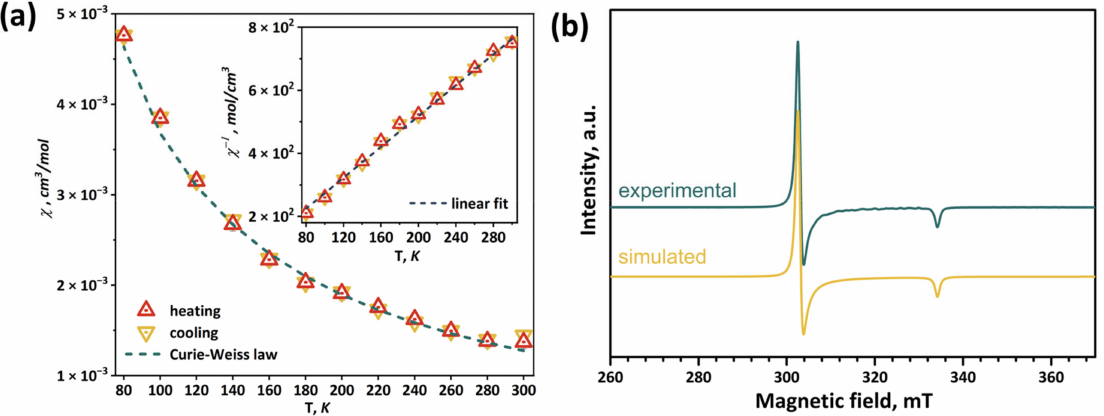
Figure 8. Temperature dependence of the magnetic susceptibility ( a ) and EPR spectrum mea- sured at 77 K in comparison with simulated one ( b ) of Mo5red . Inset: linear fitting of inverse magnetic